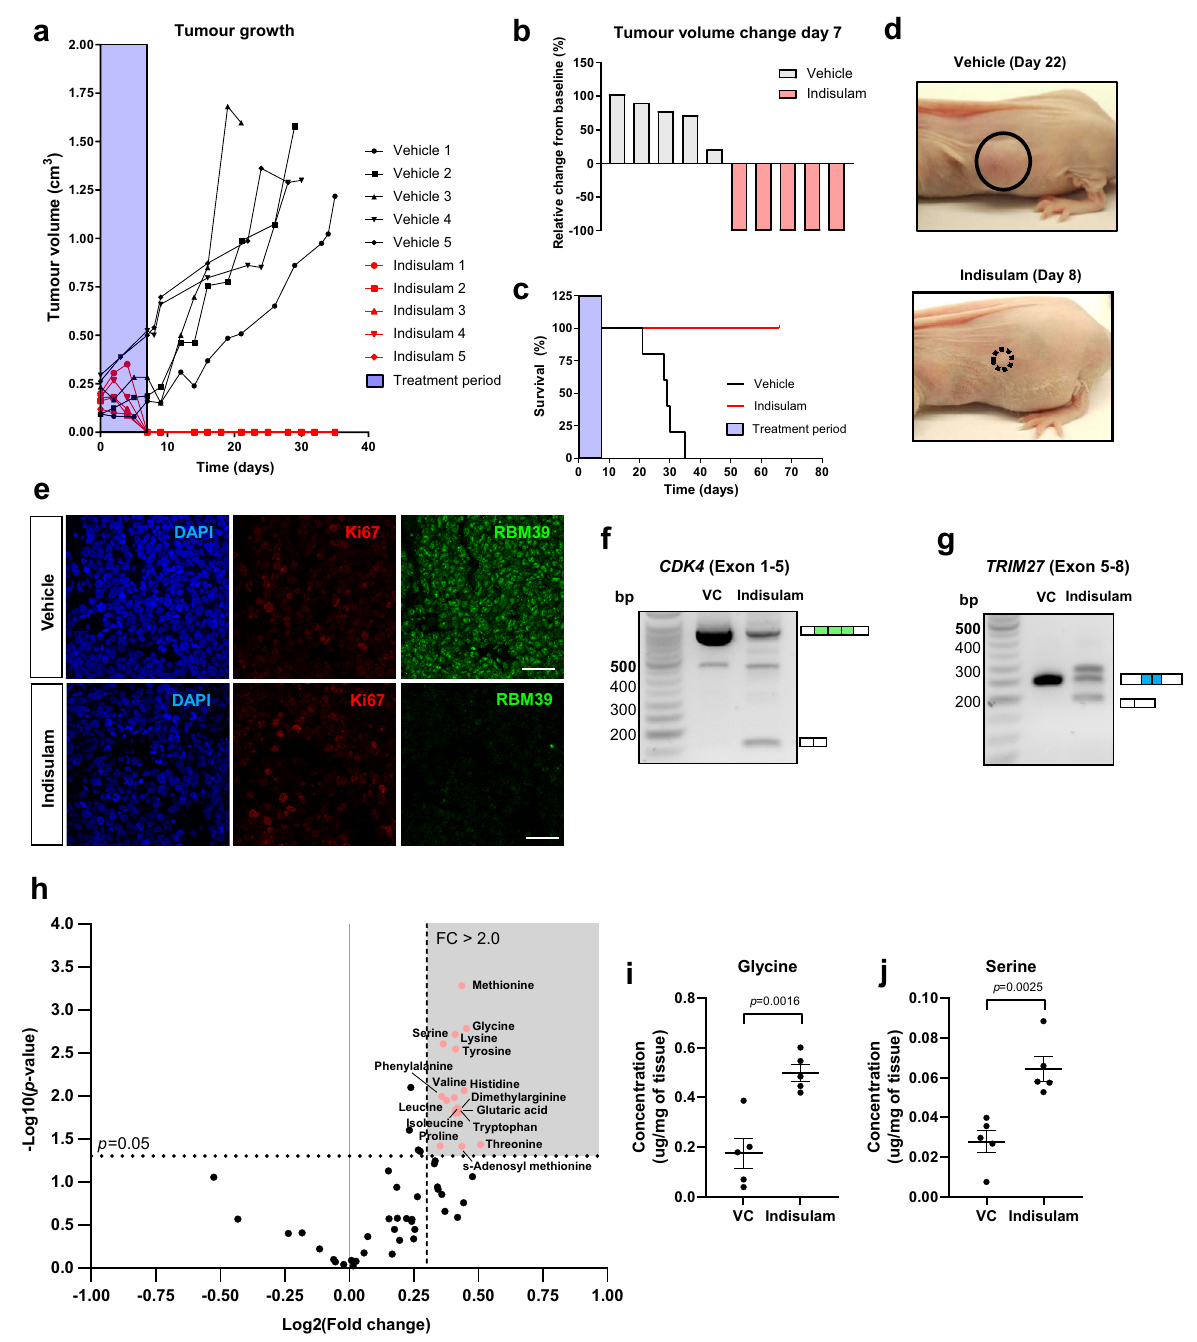
Fig. 7 Indisulam is ef fi cacious in IMR-32 neuroblastoma in vivo xenografts. a Tumour growth in mice bearing IMR-32 xenografts treated with either vehicle ( n = 5) or indisulam ( n = 5) for 8 days. Tumour volume measured every 2 – 3 days until the humane end-point was reached. b Waterfall plot showing relative changes in tumour volume of xenografts at Day 7. c Survival plot of mice bearing IMR-32 xenografts. d Representative images of IMR-32 xenografts treated with vehicle (Day 22) or indisulam (Day 8). e Immuno fl uorescent staining of RBM39 and Ki67 in IMR-32 xenograft bearing mice treated with vehicle or indisulam after 4 days. The scale bar is 20 µ m f . PCR of CDK4 in IMR-32 xenograft tumour treated with vehicle or indisulam. g . PCR of TRIM27 in IMR-32 xenograft tumour treated with vehicle or indisulam. h . Volcano plot of metabolites in IMR-32 xenograft tissues detected by LC-MS (HILIC method). i . Glycine and serine changes were detected in xenograft tumours ( n = 5 samples per group). Data are presented as mean ± SEM. Statistical analysis in i and j was determined by a two-tailed unpaired t -test. Source data is provided as a Source Data